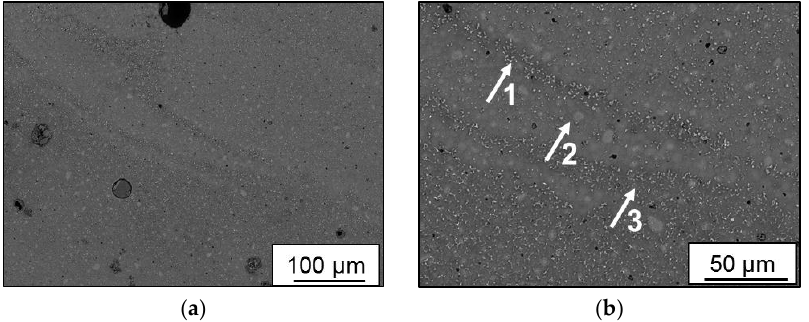
Figure 9. Melt pool boundaries in batch C (Scalmalloy ® LMD): ( a ) 200X; ( b ) 500X.